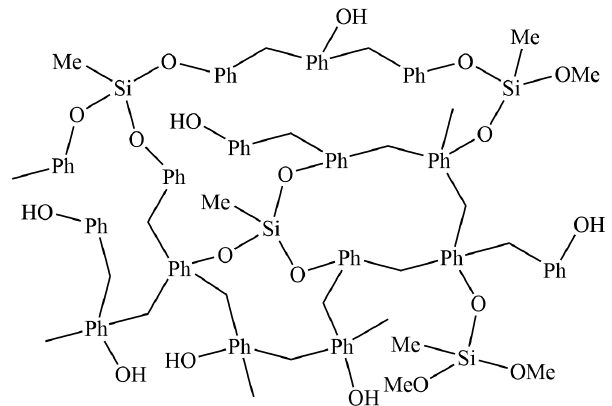
Figure 3. Structure schematic of SMPR.